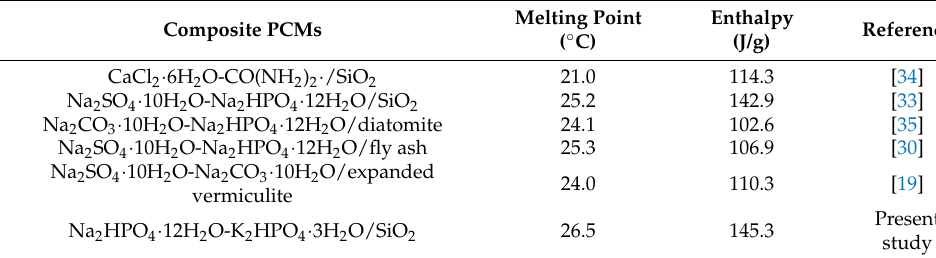
Table 4. Comparison of thermal properties of composite